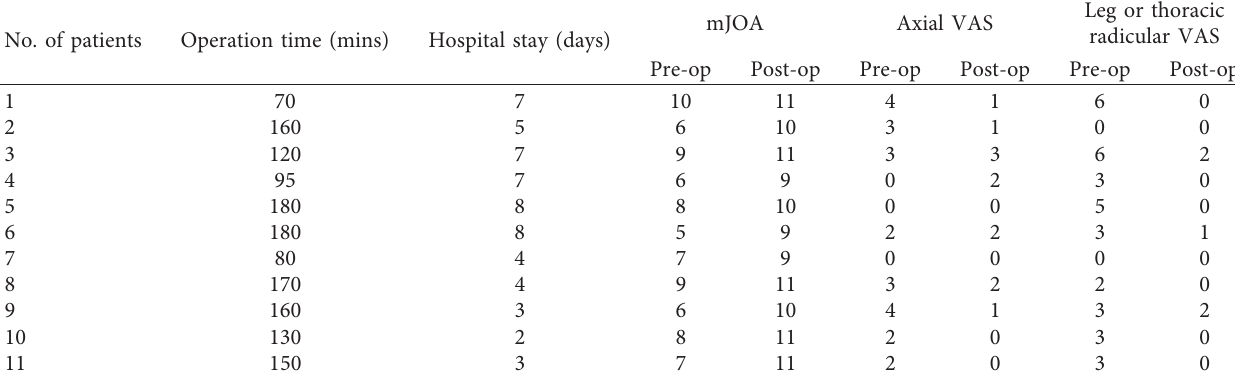
Table 2: Operative data, length of hospital stay, and pre and postoperative mJOA and VAS assessed at the last follow-up. No. of